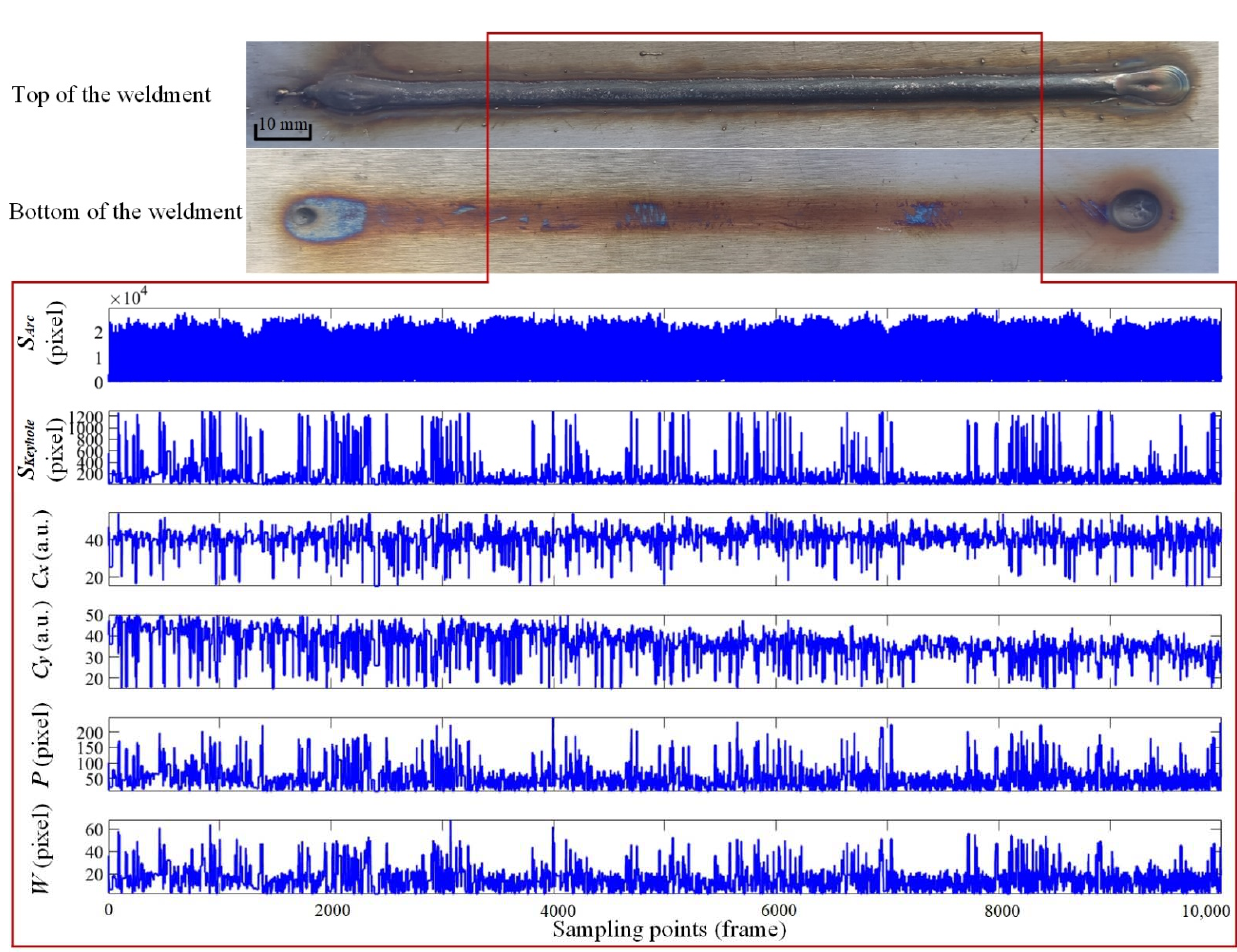
Figure 6. Visual features of non ‐ penetration (No.1) in the laser ‐ MIG hybrid welding